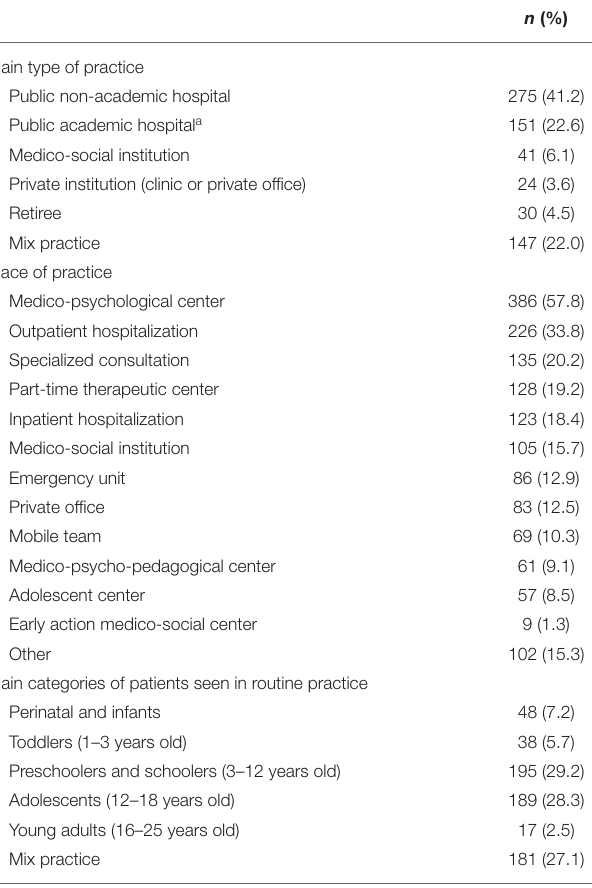
TABLE 2 | Practice-related characteristics of respondents ( n =